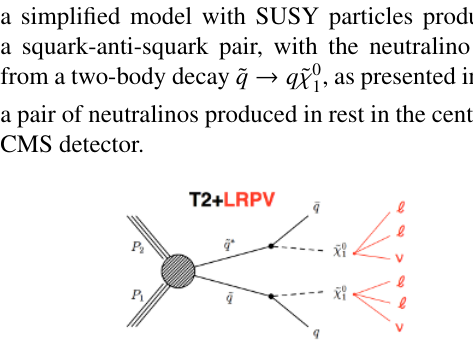
F igure 6. LRPV extensions to Simplified Model [13]. The T2 RPC simplified model is squark pair production, with ˜ q → q ˜ χ 0 and m (˜ g ) (cid:29) m (˜ q ). The neutralinos decay to two charged leptons and a neutrino via an LRPV term.